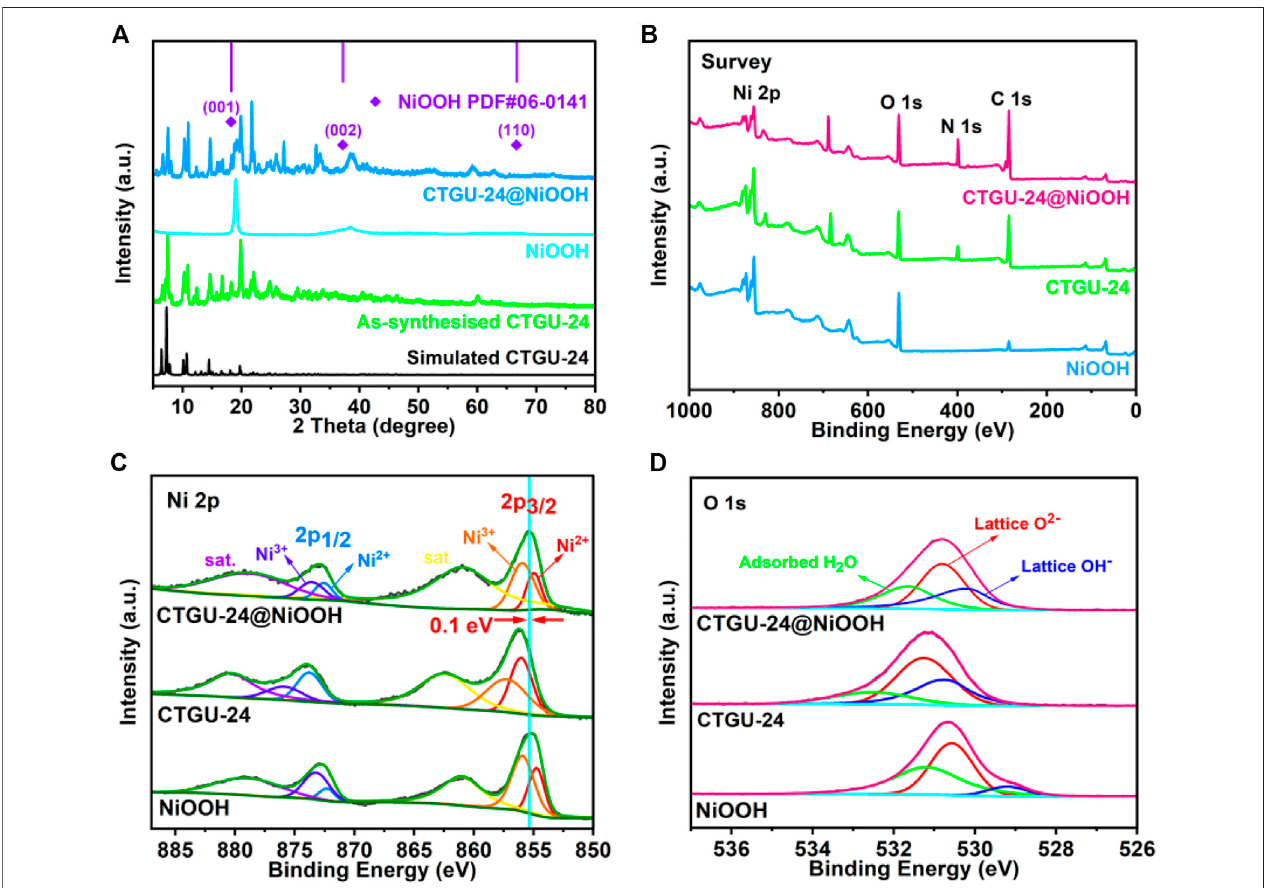
FIGURE 2 | (A) PXRD patterns of simulated CTGU-24, as-synthesized CTGU-24, NiOOH, and CTGU-24@NiOOH. XPS of the survey scan (B , C) Ni 2p and (D) O 1s of NiOOH, CTGU-24, and CTGU-24@NiOOH.